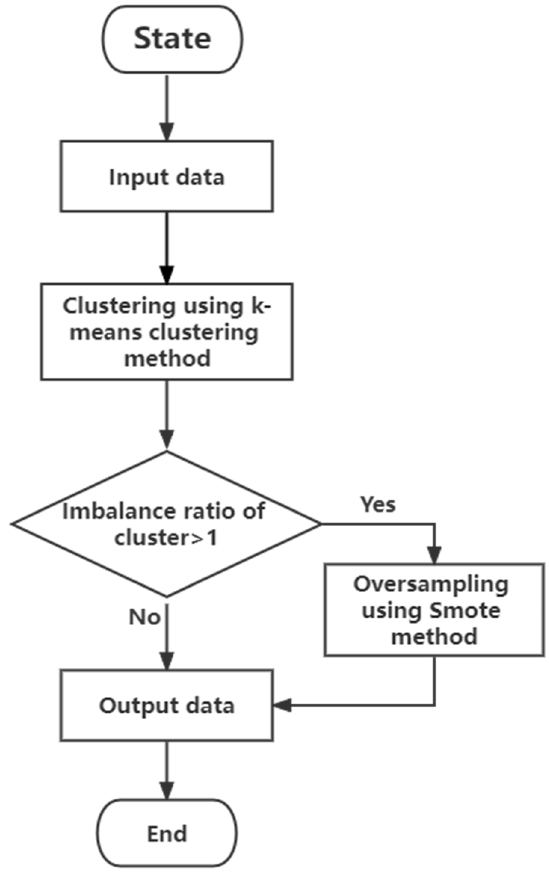
Figure 2. K-means SMOTE upsamples the security area and eliminates the imbalance within the